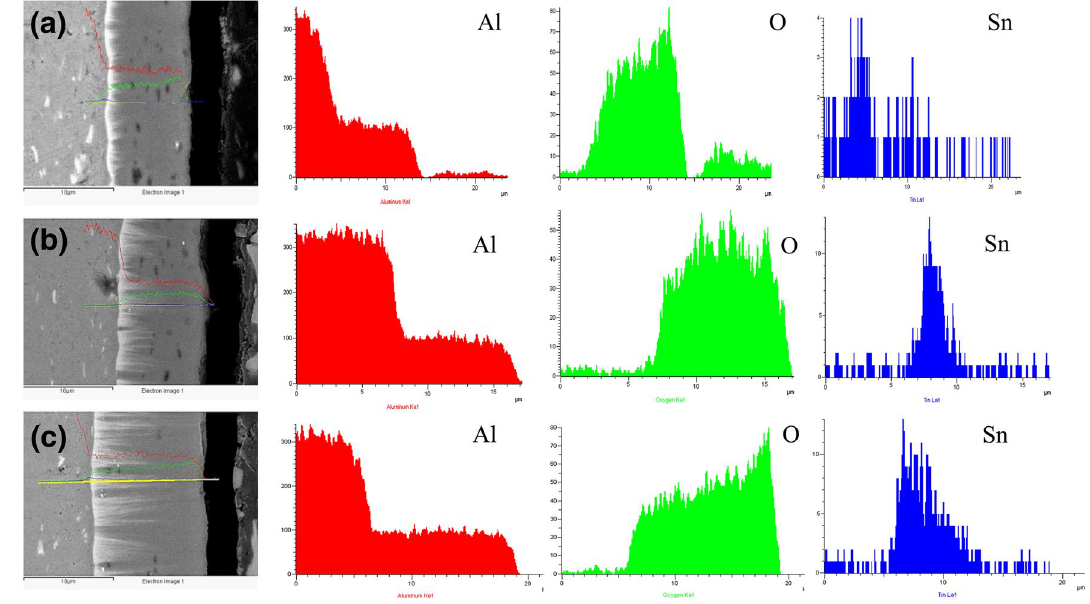
Fig. 3 SEM–EDX line scanning profiles of a Sn–Al